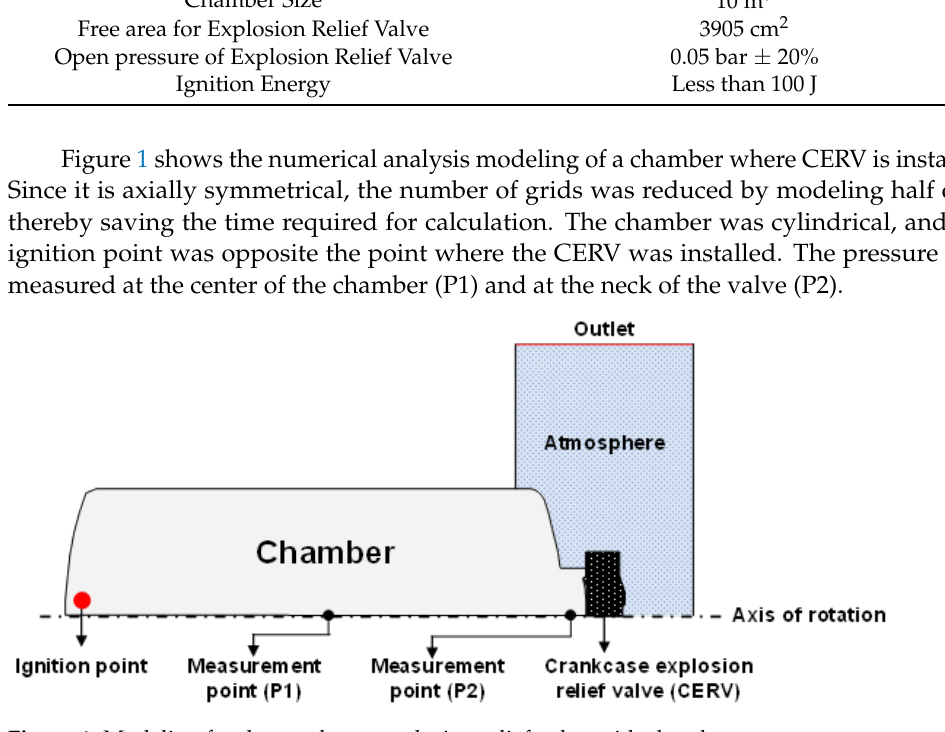
Figure 1. Modeling for the crankcase explosion relief valve with chamber.